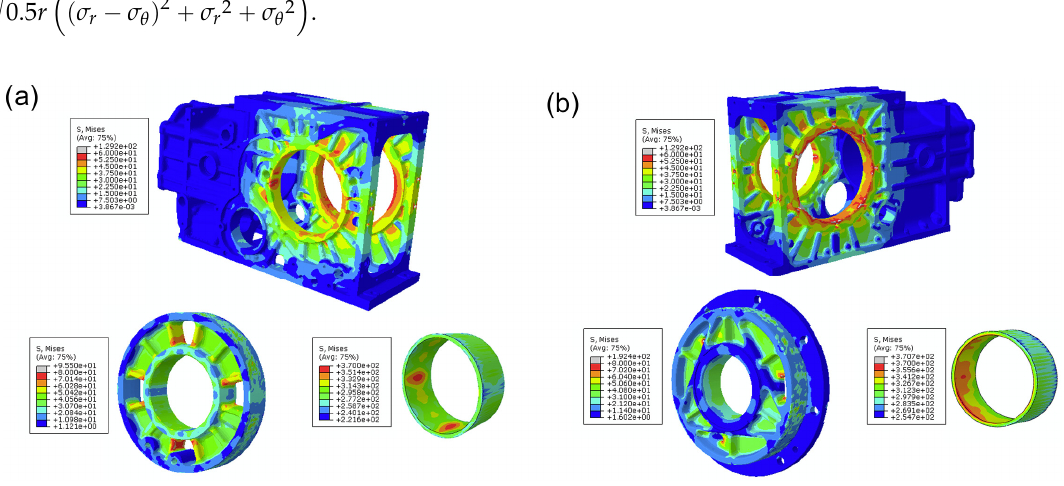
Table 6. Comparison of the von Mises stress on contact surface between analytical method and